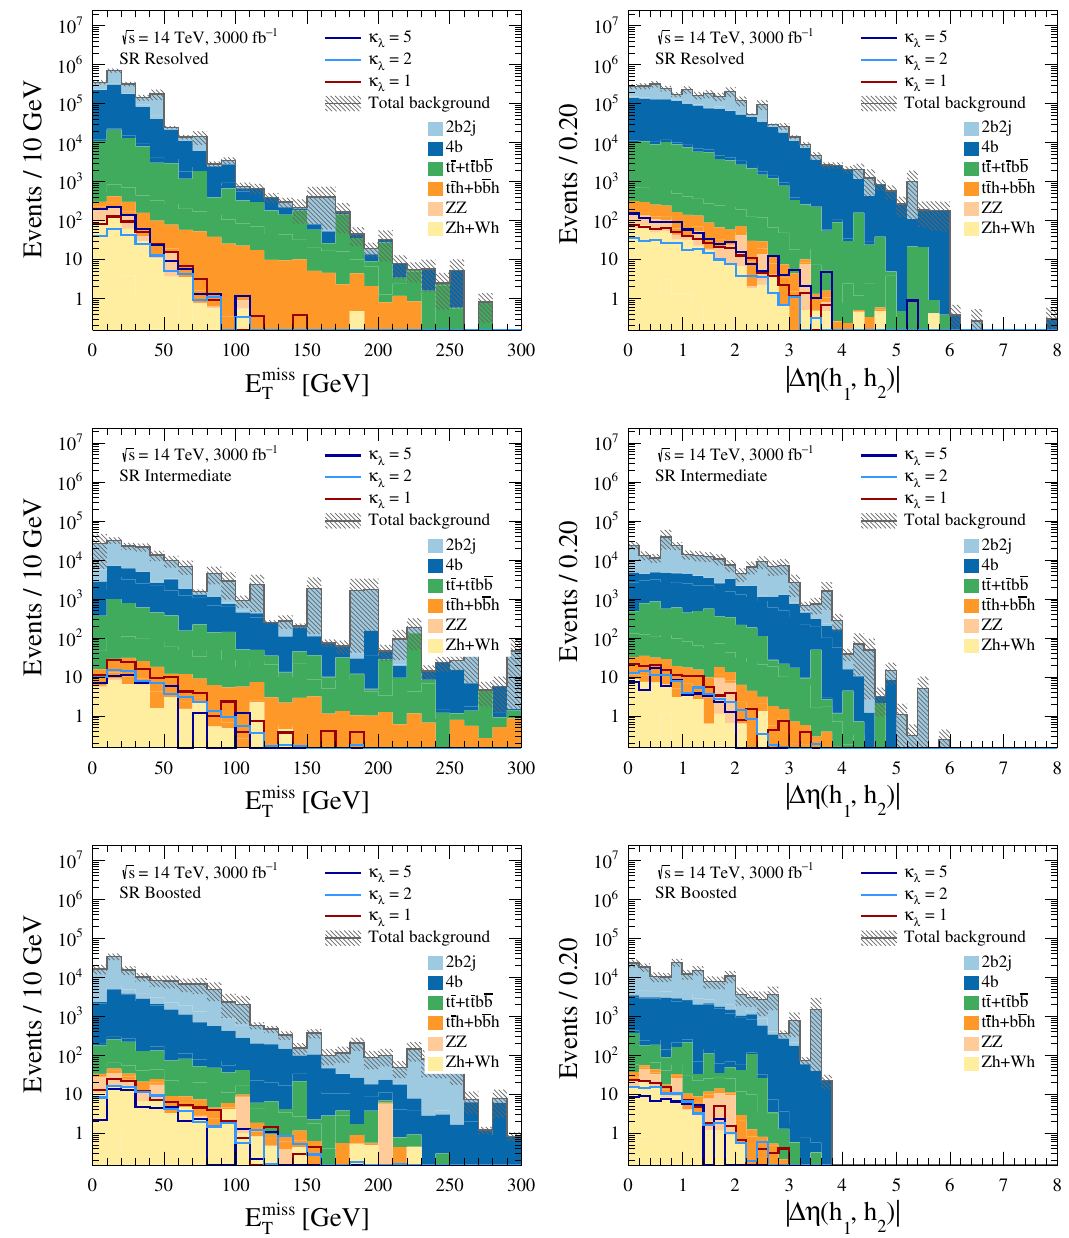
Figure 18. ‘ N − 1 ’ distributions with all signal region event selection applied except for the variable being plotted. Displayed are various signal (lines) and backgrounds (stacked filled) for (left) the magnitude of the missing transverse momentum E miss and (right) the pseudorapidity T difference of the two Higgs candidates ∆ η hh for the baseline analysis in the (upper) resolved, (middle) intermediate and (lower) boosted